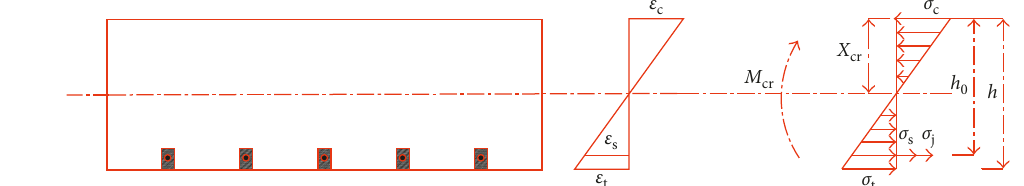
Figure 52: The strain and stress profile of the cross